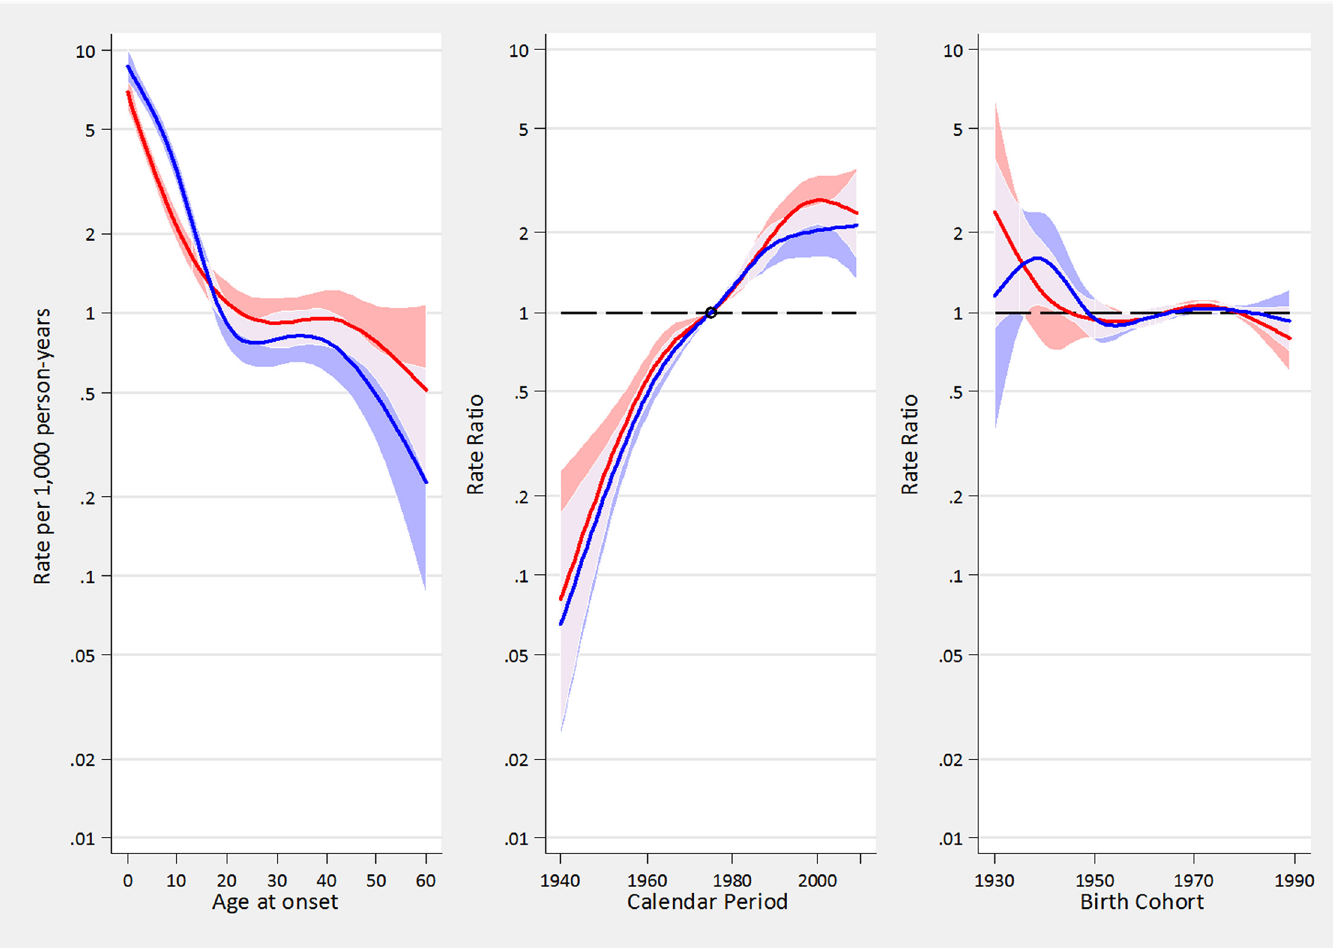
Fig 3. A-C. Estimated effects from the APC models for asthma incidence rates in males (blue tonalities) and females (red tonalities). Fig 3A represents the age-specific incidence rates, referred to the reference period 1975; Fig 3B represents the merged period and drift effects (rate ratios), with linear increasing trend determined by the drift, and deviations from linearity (curvature) determined by the period effect; Fig 3C represents the birth cohort effect. The respective regions surrounding the lines provide the 95% confidence intervals (95%CI). Overlapping 95%CI are highlighted with lighter areas.